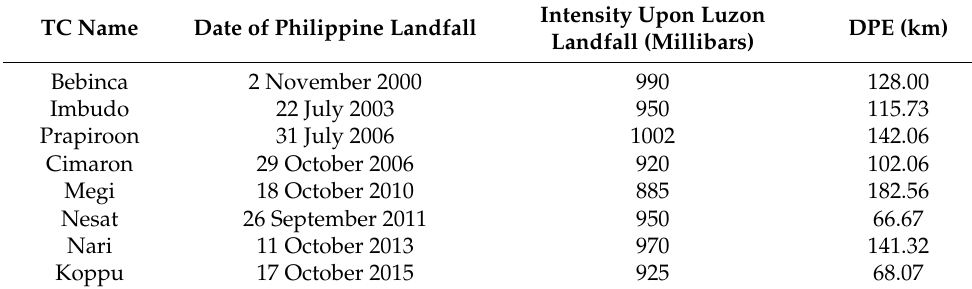
36.70 km, mean of 118.31 km, and median of 121.86